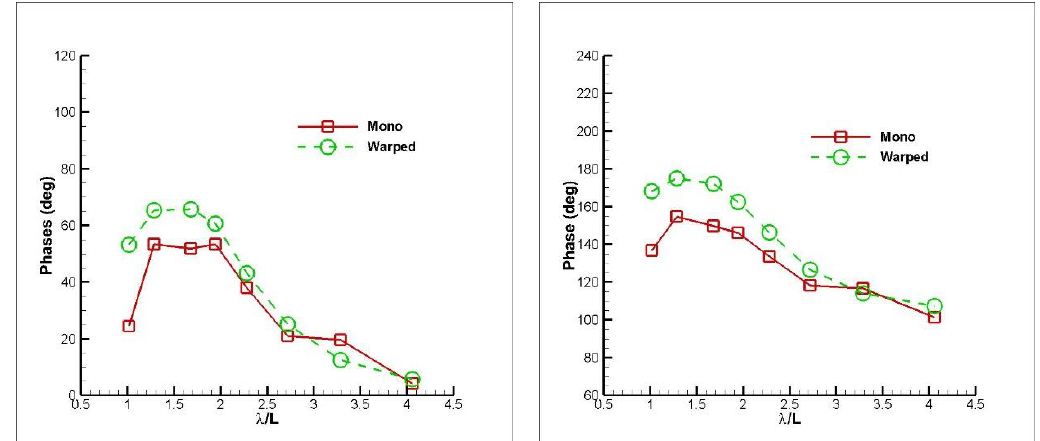
= 2.82. J. Mar. Sci. Eng. 2020 , 8 , x FOR PEER REVIEW B